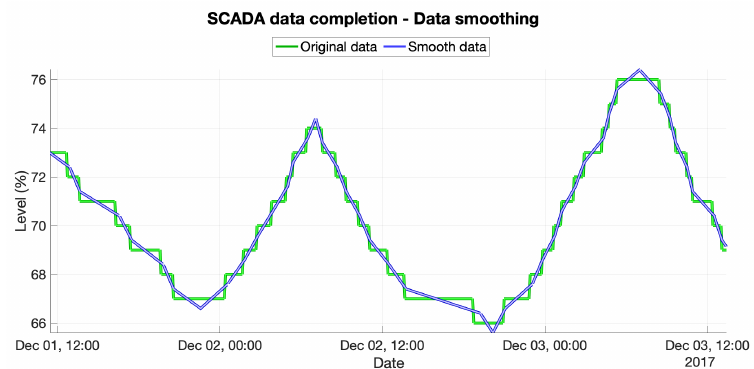
Figure 4. Smoothing process applied to the level sensor signal before the data tensorization